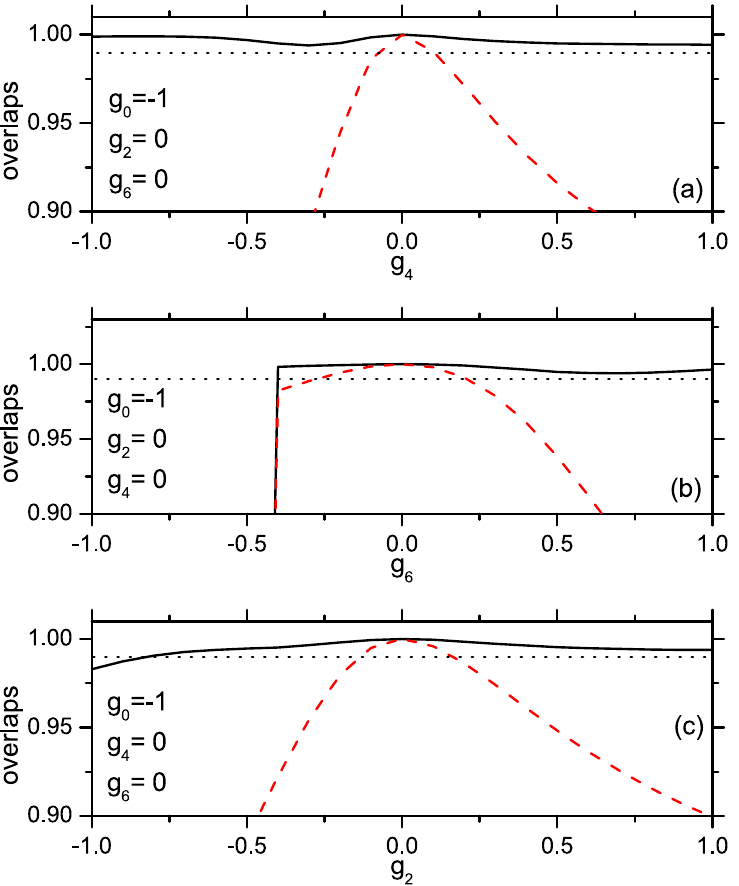
Figure 3. The overlaps � � 0 | P (ψ 3 ψ 3 ) 0 � (solid line) and � � 0 | P (χχ) 3 0 � (dashed line) against g 4 , g 6 , or g 2 . In Fig. 3a–c, The varying strength is moving up along the left boundary of Fig.2b,a,c, respectively. The dotted horizontal line marks the value